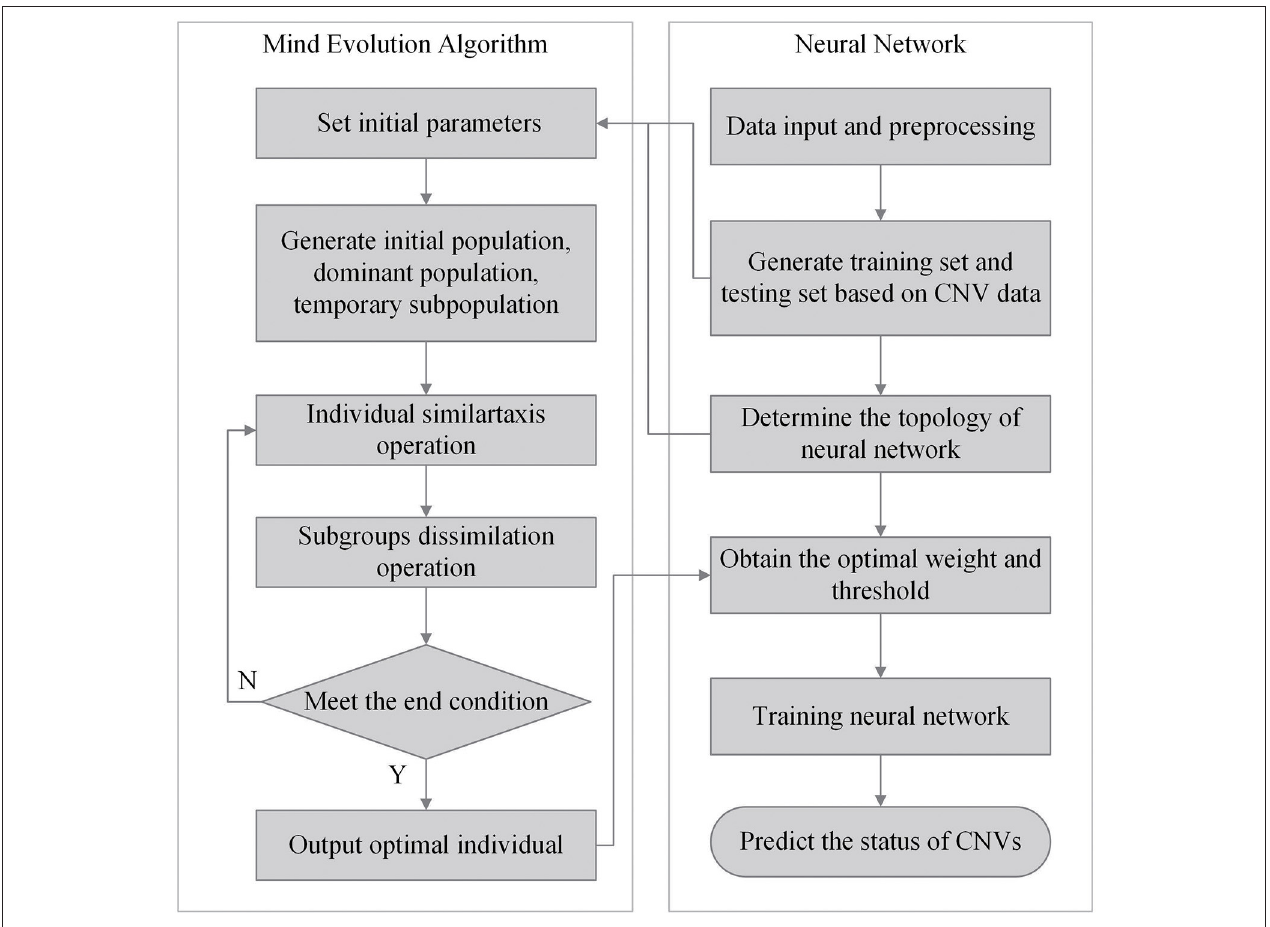
FIGURE 4 | Flowchart of the network model with MEA.